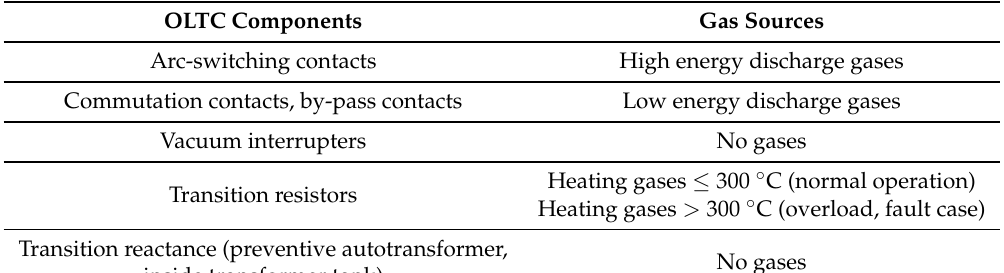
Figure 3. OLTC classification (reprinted with permission from CIGRE [30], c (cid:13) 2010). Table 3. Gas source based on OLTC design (reprinted with permission from CIGRE [30], c (cid:13)